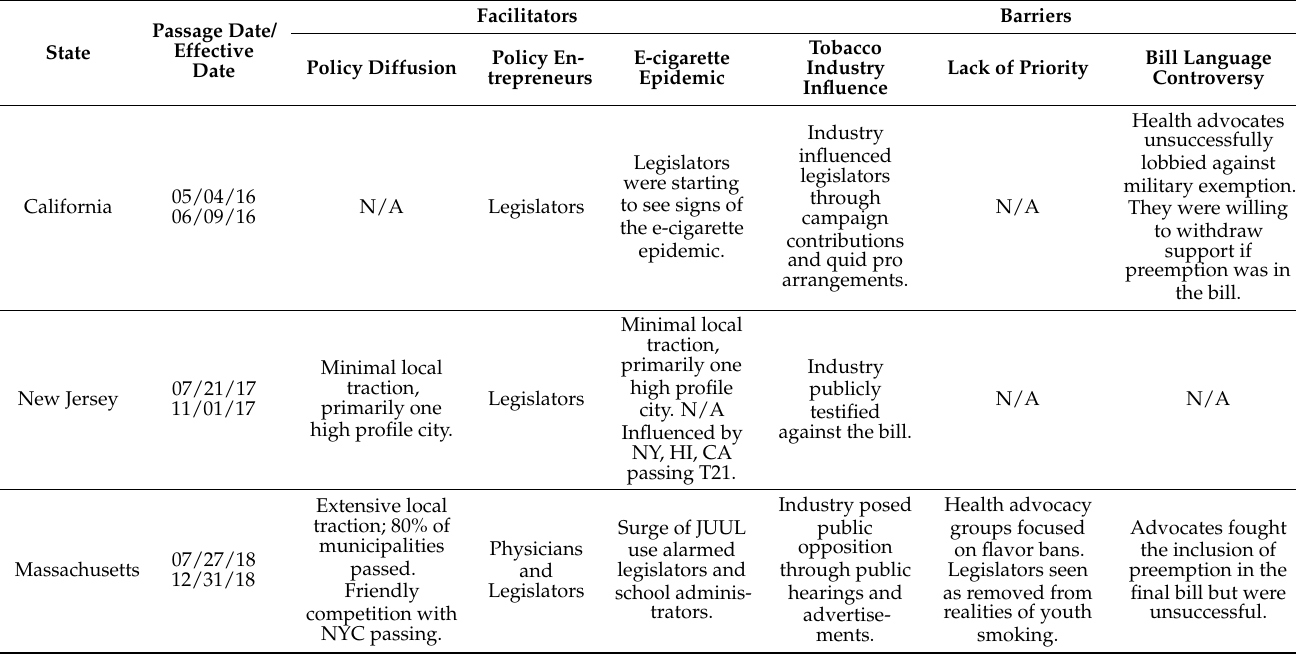
Table 2. Summary of state-level facilitators and barriers to state Tobacco 21